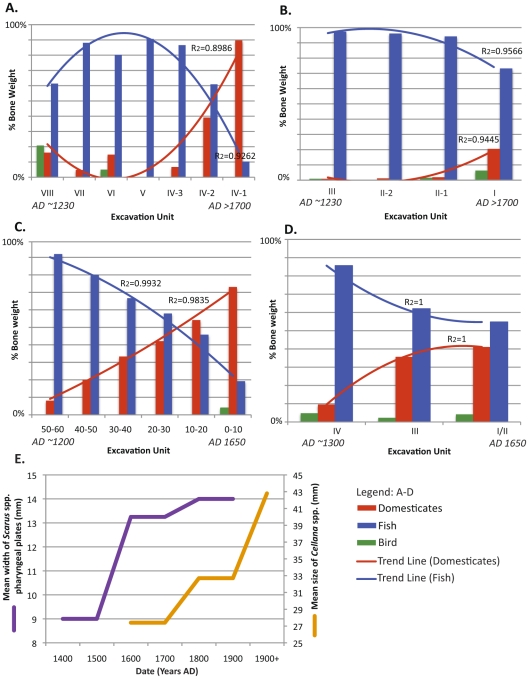
Trends in faunal bone remains in four coastal middens (A–D) and size changes for Scarus spp. (parrotfish) and Cellana spp. (intertidal limpets) (E) recovered from archaeological excavations in the Hawaiian archipelago.Midden remains show decreases in marine fish and increases in domesticated mammals (pigs [Sus scrofa] and dogs [Canis familiaris]) through time, suggesting a change in basic subsistence patterns in Hawaiian prehistory with a decreased reliance on fish versus domesticates. Increases parrotfish and limpet species occurred from the late prehistoric and early historic period (∼AD 1400–1900+) suggesting release of these populations from exploitation pressure (E). Middens analyzed include the following sites: (A) Beach profile 1, and (B) Beach profile 4, Ke‘e Beach, Hā‘ena, Kaua‘i [36], [104], (C) Hālawa Dune Site, Moloka‘i [105], [106]; and, (D) Kuakini cave sites, Kailua-Kona, Hawai‘i Island [107]. Data for Scarus spp. are from Site 4853-1, Bellows Beach, Waimanalo, O‘ahu [39]; Cellana spp. data are from the Kalaupapa Peninsula, Moloka‘i [50].